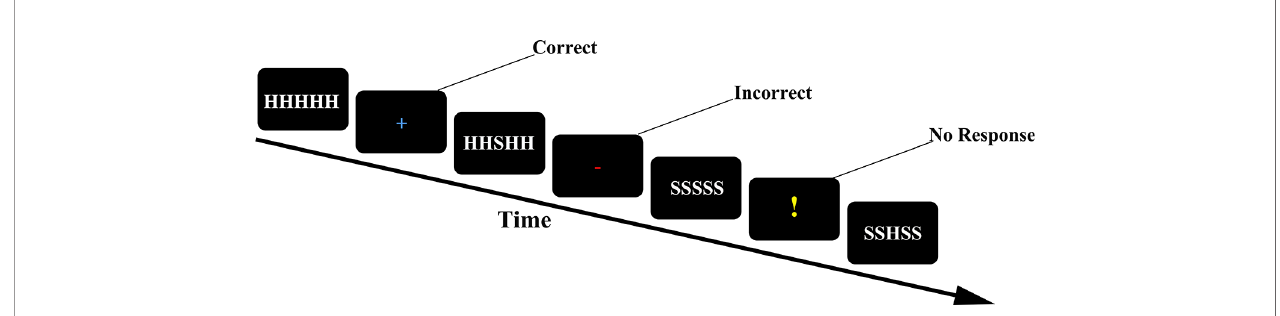
FIGURE 1 | Trial structure of the fl anker task. Feedback was informative ( “ + ” for correct; red for incorrect; “ ! ” for missing or not responding in